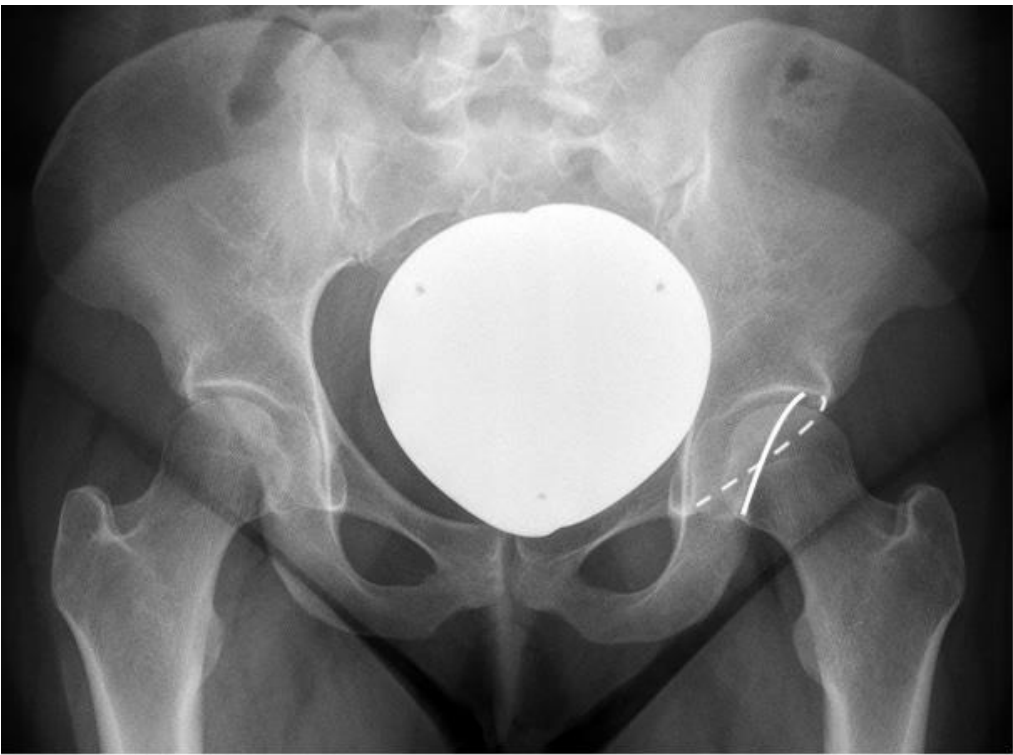
Figure 3. A 23-year-old female with a symptomatic acetabular retroversion on the right side. Radiological criteria: Lateral center edge angle (LCEA): 25.1°, Acetabular index: 12.1°, Extrusion index: 22.7%, Anterior wall coverage: 31.6%, Posterior wall coverage: 29.2%, Sharp angle: 39.7°. It is to be underlined that the problem is not a potential anterior conflict only, but posterolateral dysplasia. Dashed white line: Anterior wall; White line: Posterior wall.